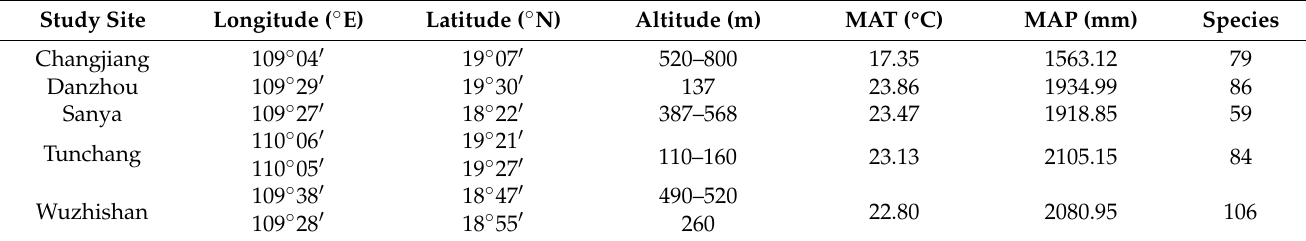
Table 3. Overview of the study